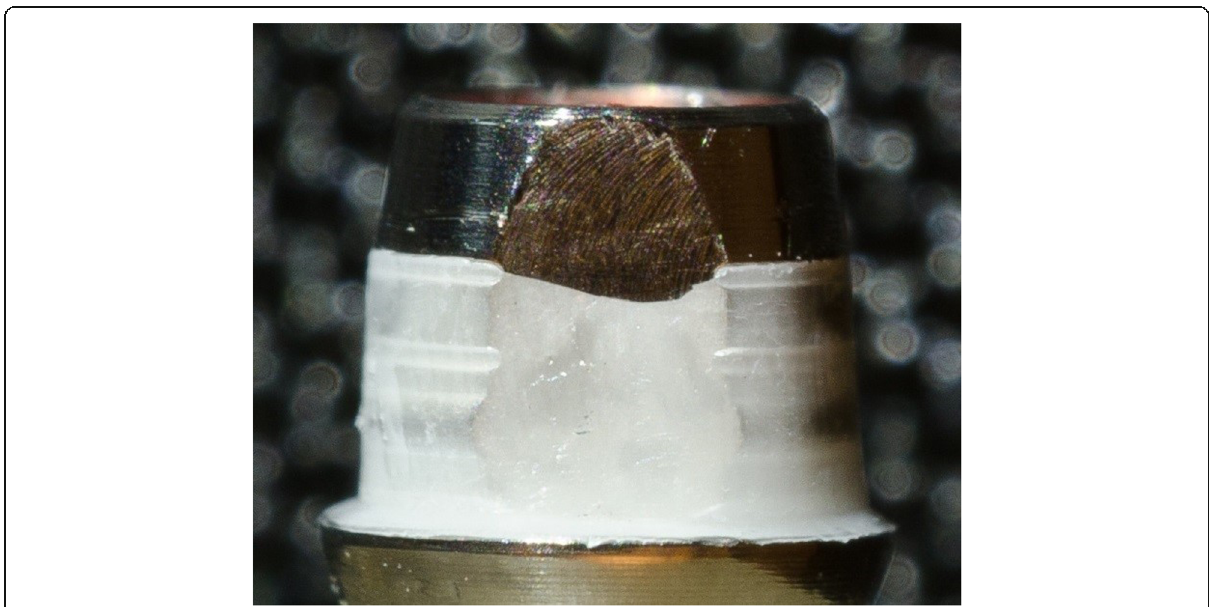
Fig. 7 Cohesive cement fracture (type III; implantlink semi